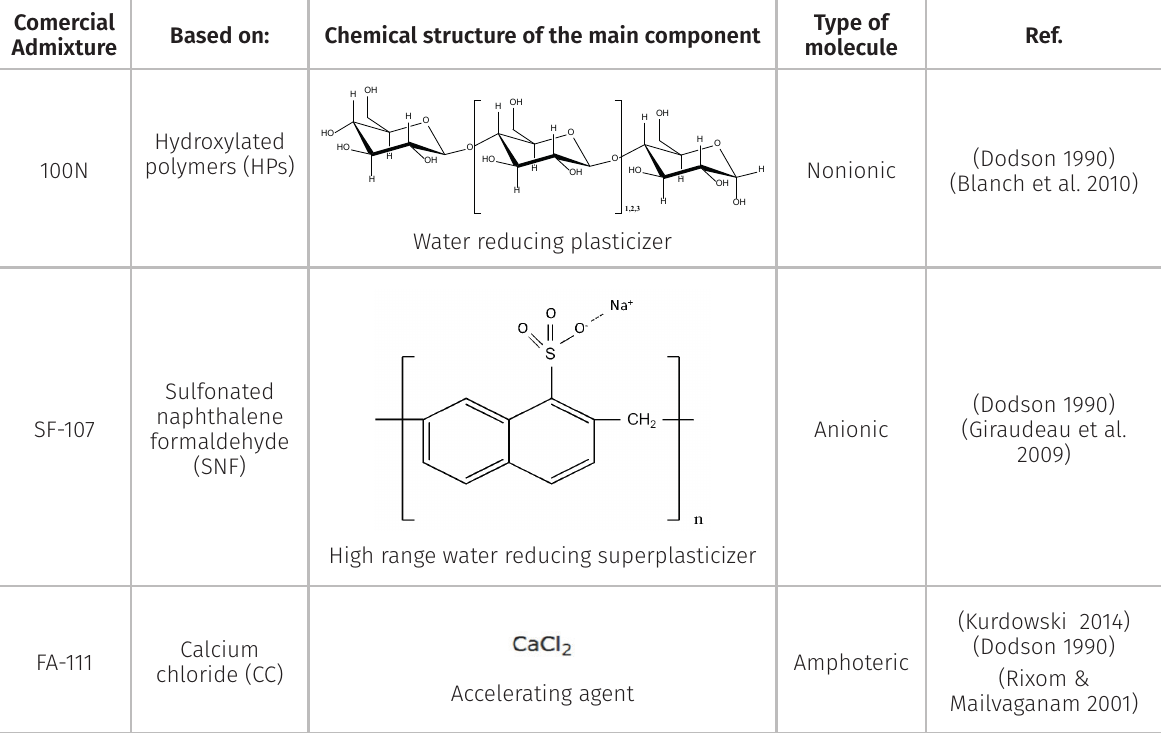
Type of Ref. molecule